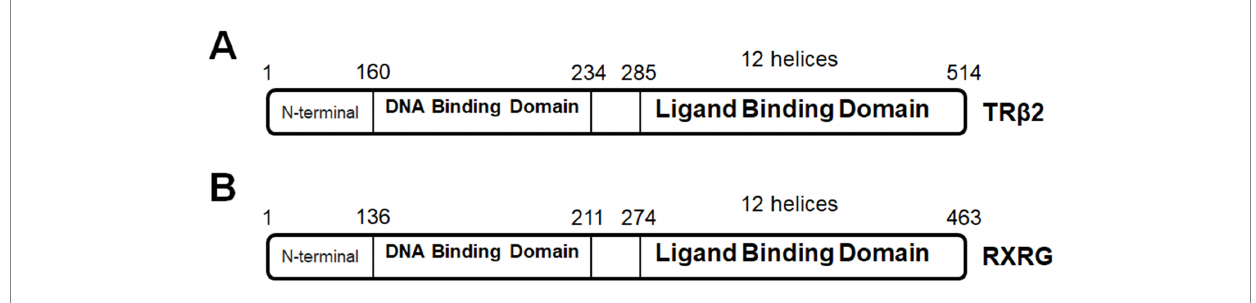
FIGURE 5 (A) TR β 2 protein domains. (B) RXRG protein